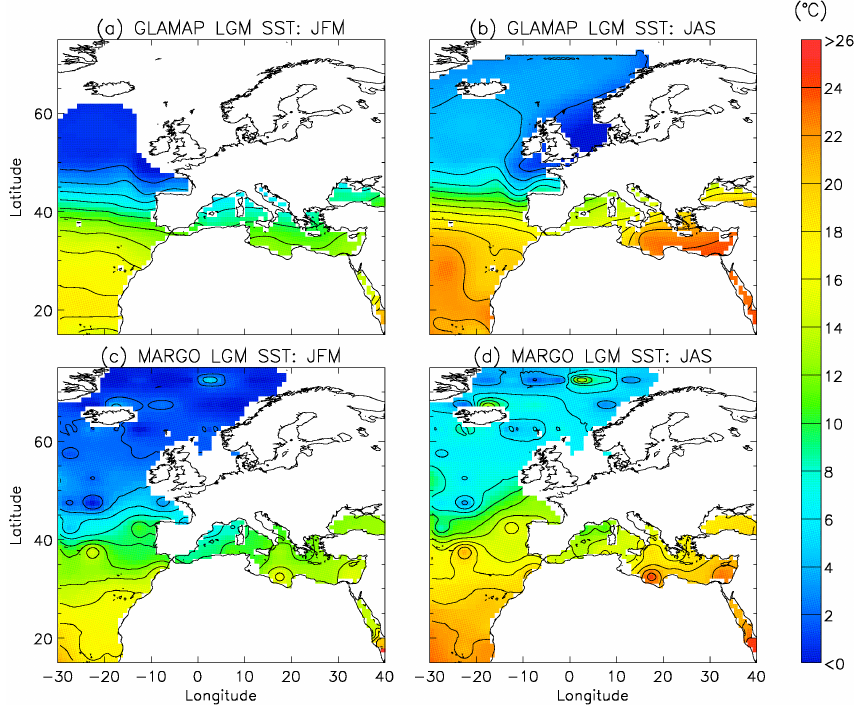
Figure 4. Climatological SST from the LGM as determined by Paul and Schäfer-Neth (2003) for (a) winter and (b) summer and by MARGO Project Members (2009) for (c) winter and (d) summer. The maps of Paul and Schäfer-Neth (2003) are from the Global Ocean Atlas (GOA; http://www.glacialoceanatlas.org/) and are overplotted with a sea ice template if any of the three months represented in the field have ice cover. The MARGO-interpolated fields (also from GOA) were calculated using a simple interpolation method based on an inverse distance-squared weighting factor using the 5°×5° summary data of MARGO Project Members (2009) with an LGM land template is derived from Peltier (1994) and ETOPO-5 (http://www.ngdc.noaa.gov/mgg/global/etopo5.HTML). No sea ice template was provided with this this dataset.